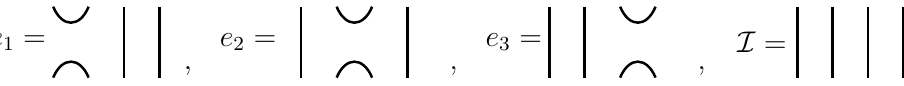
Figure 13 . The graphical interpretation of the Temperley-Lieb loop representation.